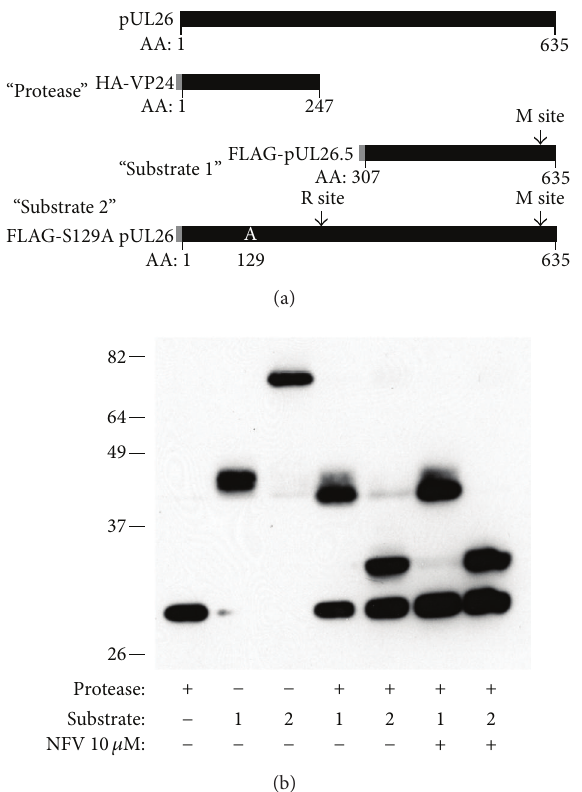
Figure 2: NFV does not inhibit activity of the HSV-1 protease. The coding sequence of the full-length protein product of UL26 ORF (pUL26) and the expression proteins employed are diagramed in panel (a). Transfection vectors were constructed to express the VP24 protease with an N-terminal HA tag (“protease”), the pUL26.5 with an N-terminal FLAG tag (Substrate 1), or the S129A pUL26 mutant inactive protease-scaffold protein with an N-terminal FLAG tag (Substrate 2). Tags are depicted in grey at the left end of each con- struct. The release (R) and maturation (M) cleavage sites are shown. After transfection into HEK293-T cells, construct expression and substrate cleavage were evaluated by Western blot using anti-HA and FLAG antibodies. Each protein expressed alone was of the expected size (28.8, 37.9, and 70.6 kD, resp., including tag). Similarly, coexpression of protease with each of the 2 substrates resulted in the N-terminal cleavage products of the expected sizes. The generation of substrate cleavage products was not affected by the addition of NFV at concentrations that inhibit HSV-1 replication in vitro .